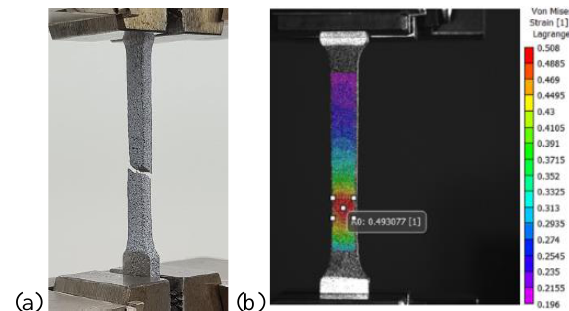
Fig. 4. Example of (a) specimen failure and (b) DIC data extraction.